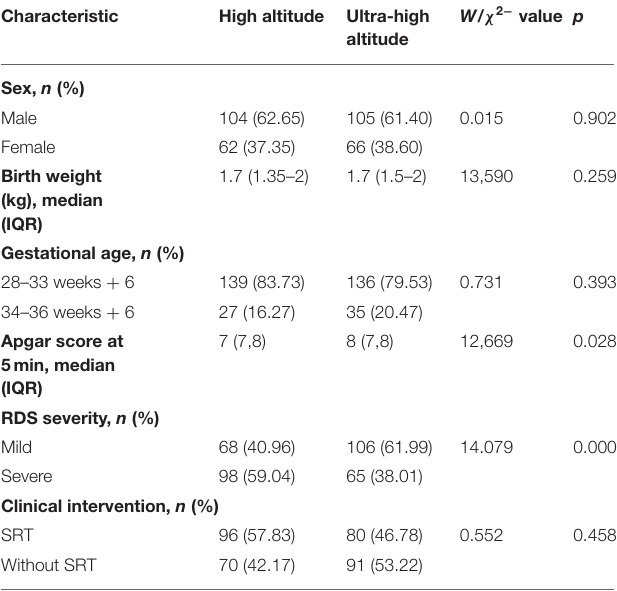
TABLE 1 | Baseline characteristics in high-altitude and ultra-high-altitude groups.